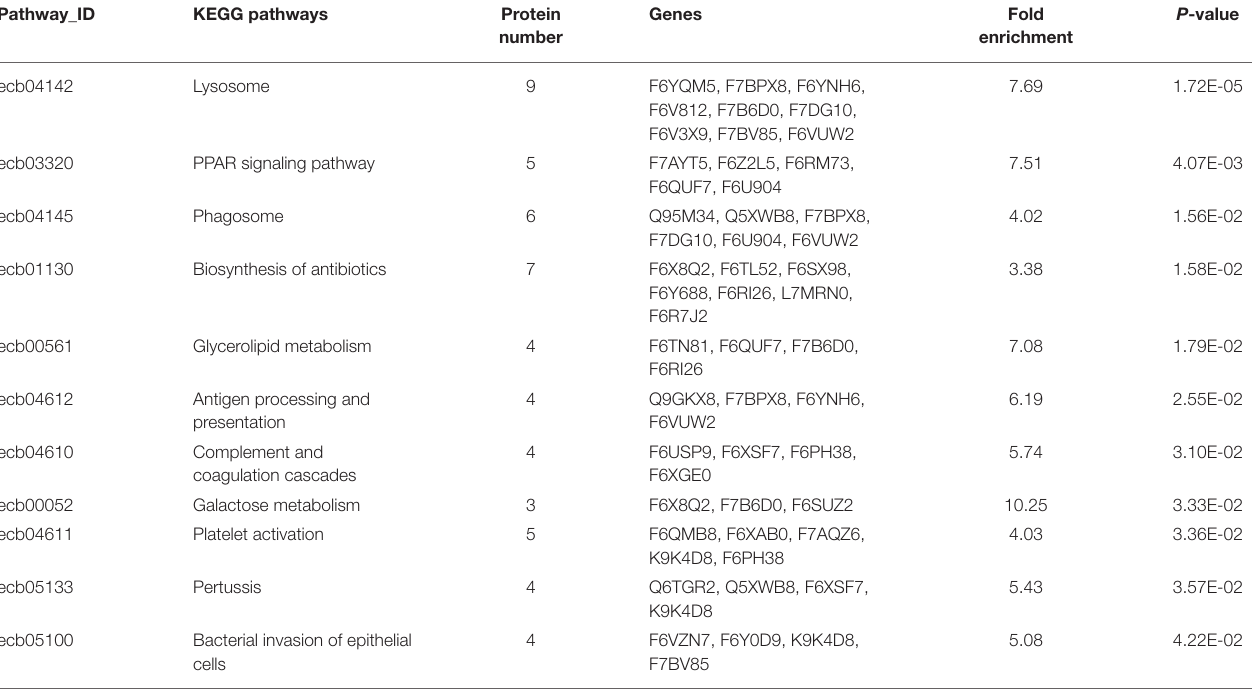
TABLE 1 | Detailed information of KEGG pathway-based enrichment of the differentially expressed proteins between DM and HM. Pathway_ID KEGG pathways Protein number